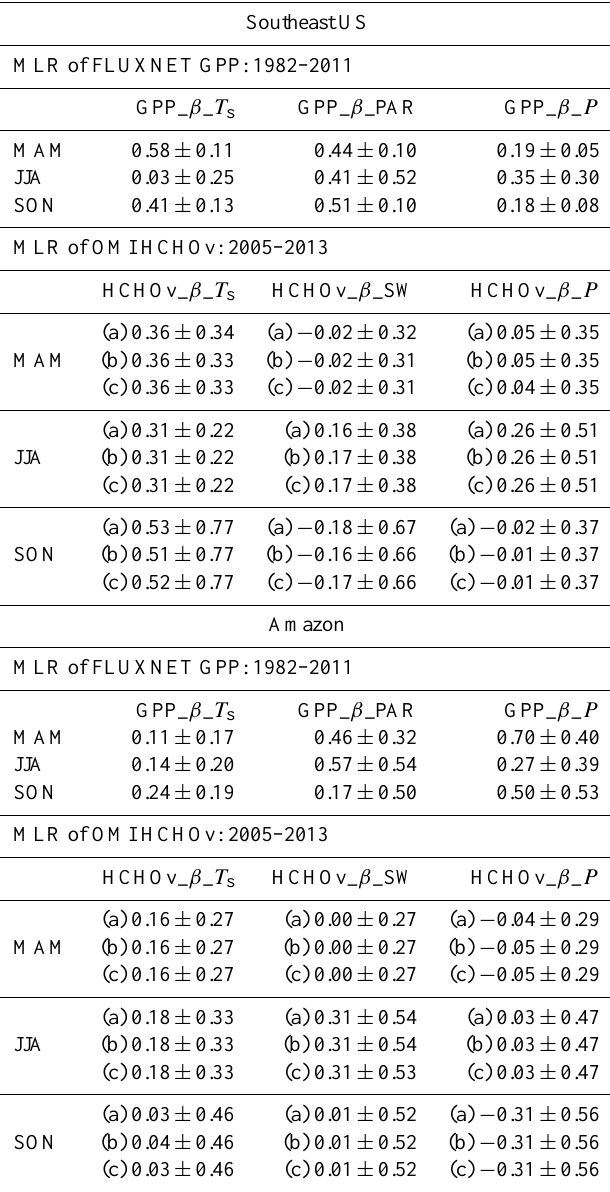
Table 2. Regionally averaged MLR β coefficients with standard deviation for GPP and HCHOv in the southeast US, defined as 31–35 ◦ N, − 94 to − 79 ◦ E, and the Amazon, defined as − 15 ◦ S to 3 ◦ N, − 76 to − 54 ◦ E. The covariance of GPP with T s , PAR and P are denoted as GPP_ β _ T s , GPP_ β _PAR and GPP_ β _ P ; the covariance of HCHOv with T s , SW and P are denoted as HCHOv_ β _ T s , HCHOv_ β _SW and HCHOv_ β _ P . In MLR of OMI HCHOv (a), (b) and (c), the OMI HCHO columns are processed using model Y-PS, Y-MEGAN and Y-MEGAN-SM,